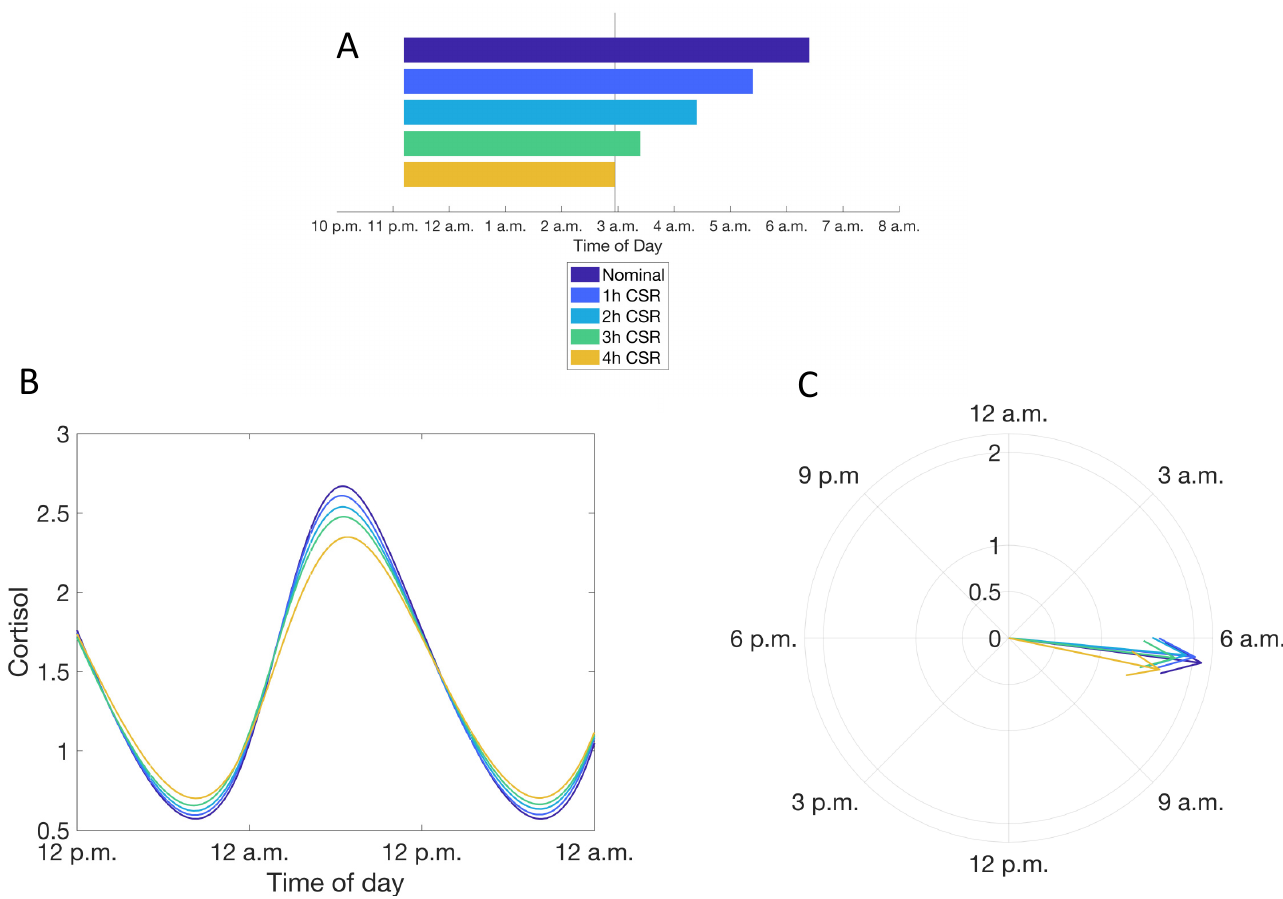
Figure 7. ( A – C ) Conditions as in Figure 5, respectively, except the CSR is adjusted by changing the scheduled wake time.